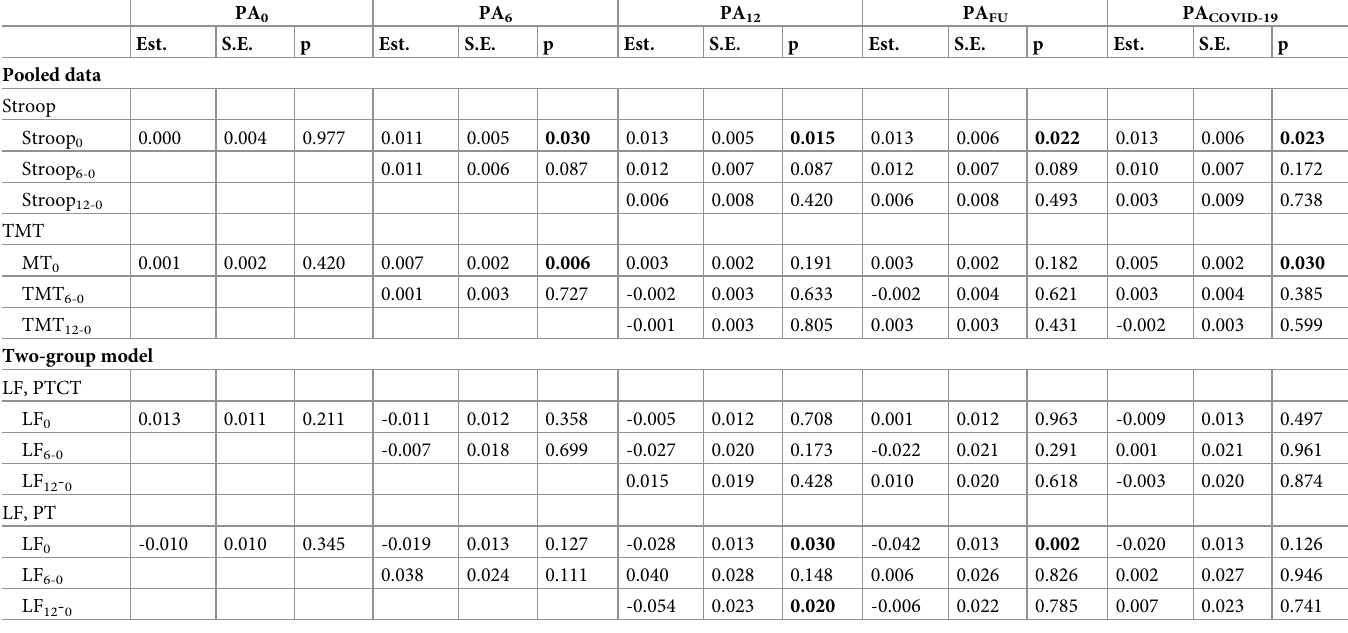
Table 5. The effects of executive functioning test performance at baseline and changes in test performance on physical activity from the longitudinal linear path model in full study sample. PA